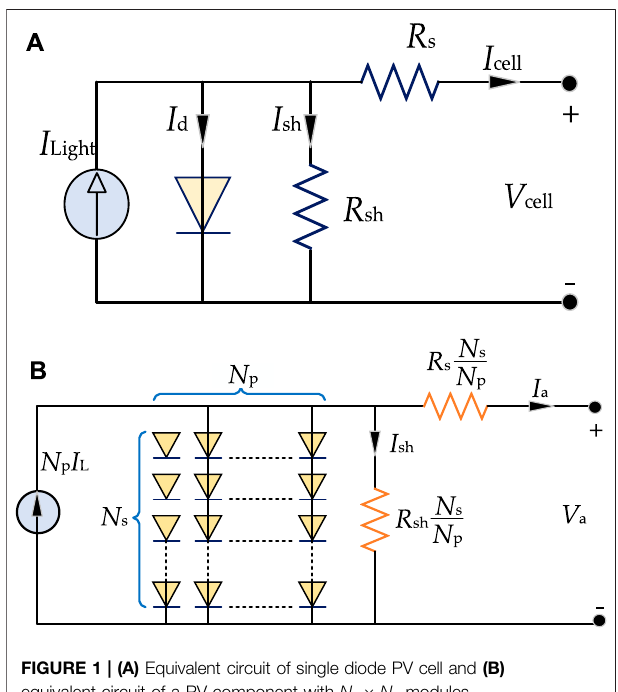
FIGURE 1 | (A) Equivalent circuit of single diode PV cell and (B) equivalent circuit of a PV component with N s × N p